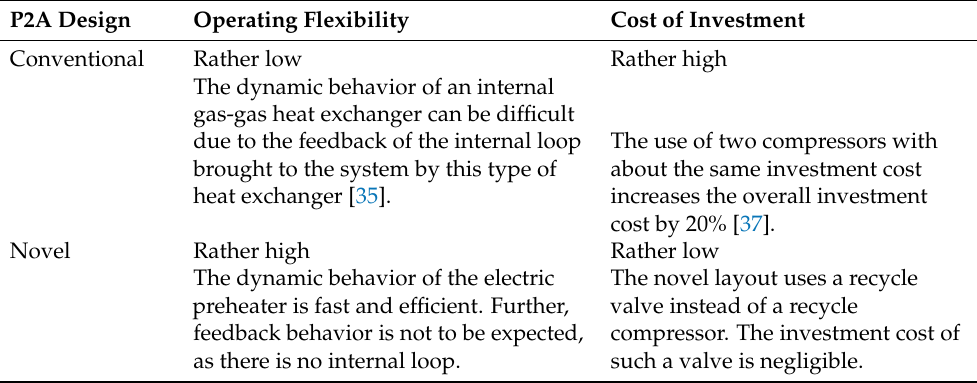
Table 1. Main differences between the novel and the more conventional P2A